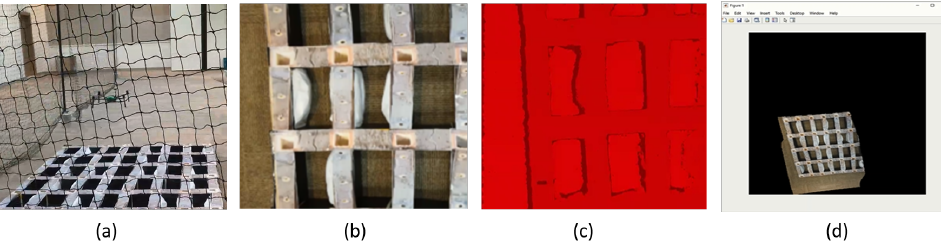
Figure 10. The multimodal depth-RGB mosaicking algorithm results in the lab environment: ( a ) shows the drone flying from a third person view. ( b ) shows the RGB view of the drone while ( c ) shows the depth view of the drone. ( d ) shows the development of the RGB orthomosaic.